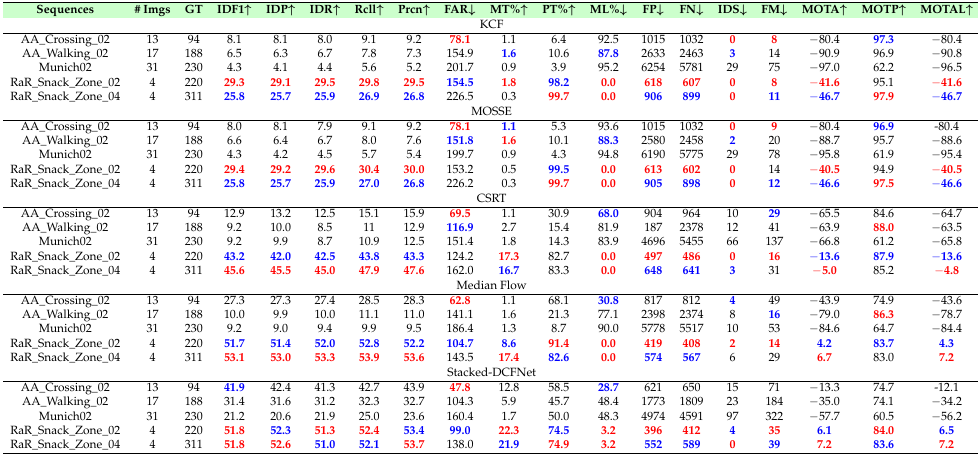
Table 6. Results of KCF, MOSSE, CSRT, Median Flow, and Stacked-DCFNet on different sequences of KIT AIS pedestrian dataset. The first and second best values of each method on the sequences are highlighted. Sequences